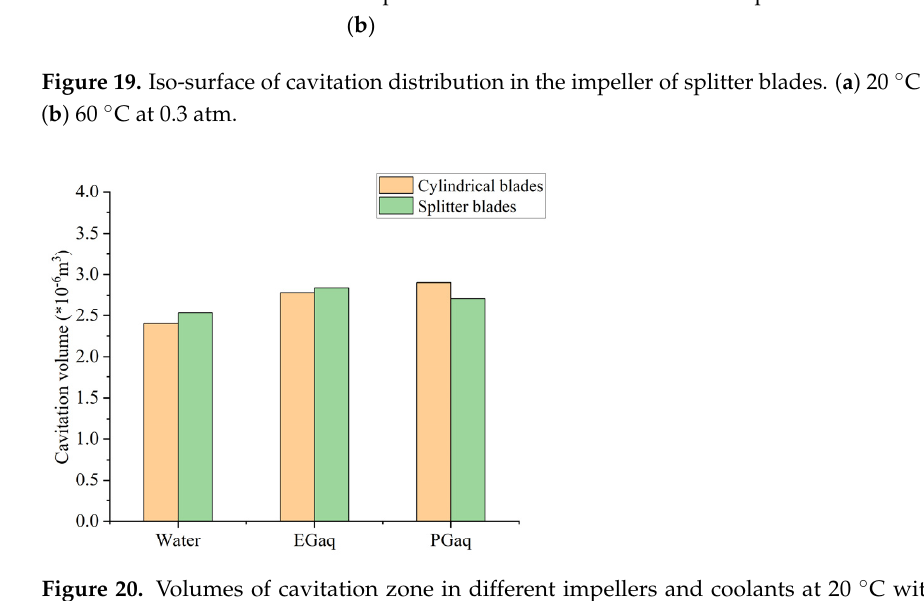
Figure 20. Volumes of cavitation zone in different impellers and coolants at 20 °C with an inlet pressure of 0.3 atm.